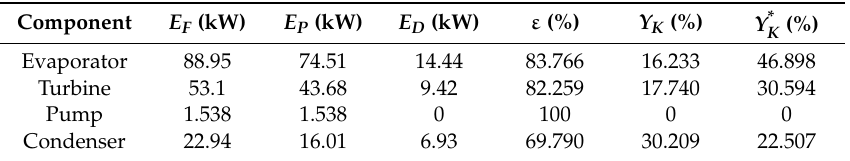
Table 5. Results from exergy calculations for BORC.